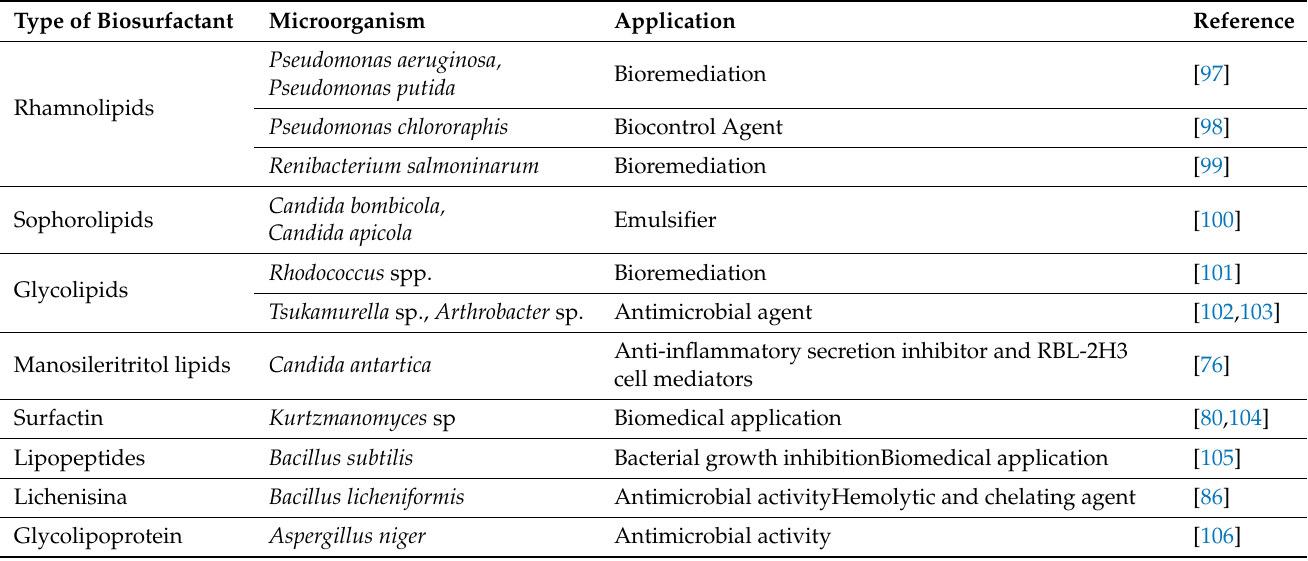
Table 2. Biosurfactants and their